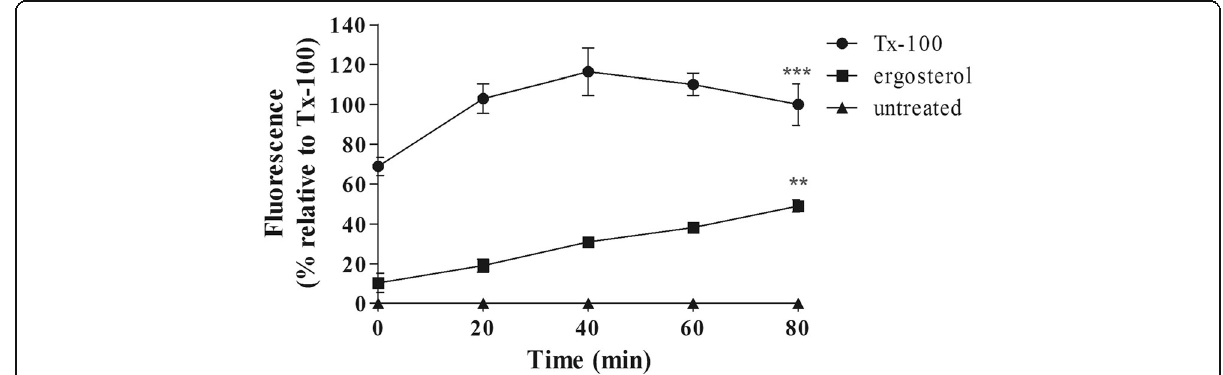
Fig. 2 Effect of ergosterol on plasma membrane permeabilization of trypomastigotes of T. cruzi . Sytox Green (1 μ M) fluorescence was measured spectrofluorimetrically every 20 min. Minimum and maximum permeabilization were obtained by non-treatment and Tx-100 0.5%, respectively. Fluorescence was quantified by calculating the mean percentages of untreated (0%) and Tx-100-treated (100%) trypomastigotes. *** p < 0.001 and ** p < 0.002. A representative assay is